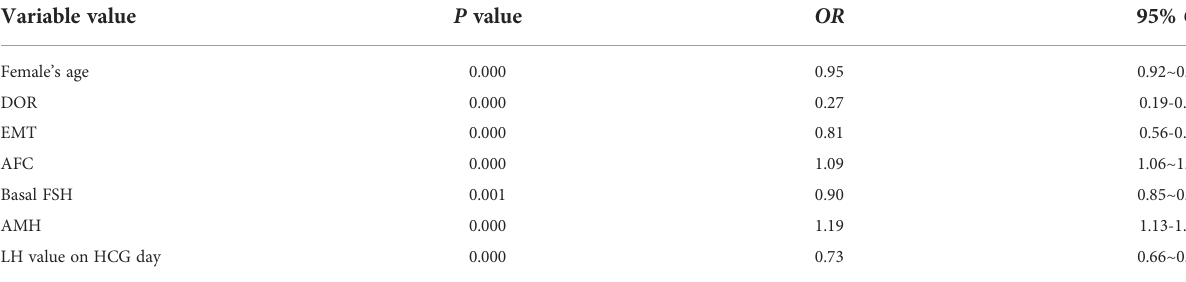
TABLE 3 Parameter variables screened by multi-factor stepwise regression.